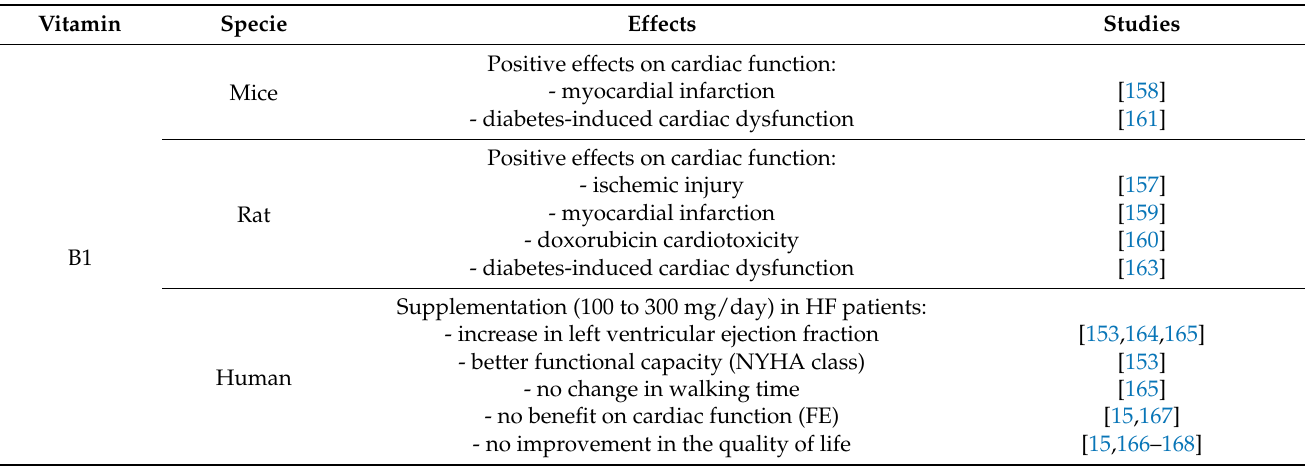
Table 1. B vitamin supplementation and cardiovascular diseases in animals and